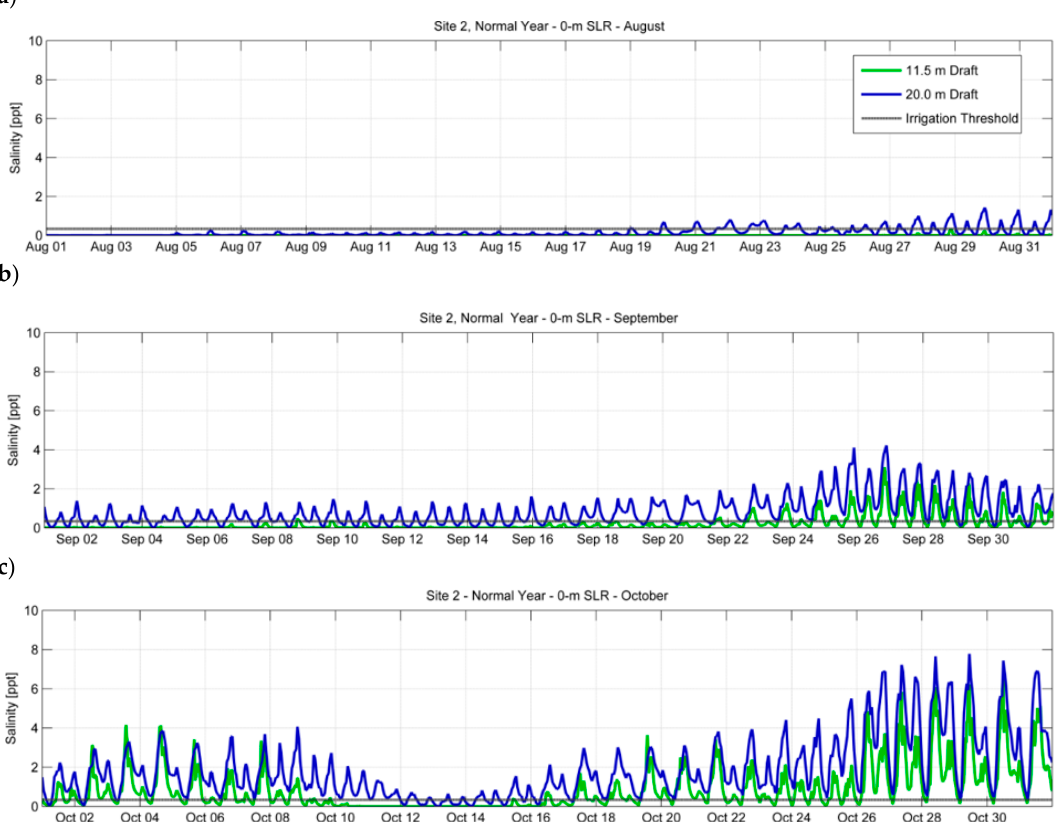
Figure 17. Time series salinity at site 2 with river channel depth capable of accommodating vessels drafting 11.5 m and 20.0 m with 0-m SLR during irrigation period. ( a ) August; ( b ) September; ( c ) October.